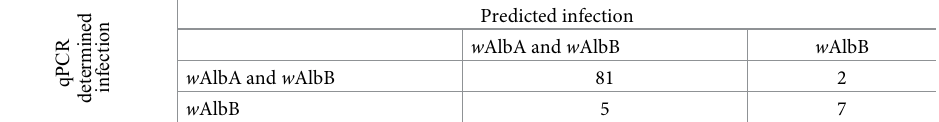
There was a significant association between w AlbA and w AlbB infections in superinfected Ae . albopictus females in most populations (Fig 6A–6F). Correlations between densities of the two infections were always positive and significant (P < 0.05) in the samples and regression analyses where the w AlbA density was used to predict the density of w AlbB were also always significant with positive slopes in each case (Fig 6). On the other hand, we found no associa- tions between the density of the infections in males in the two populations with moderate sam- ple sizes ( > 10) available for analyses (Fig 6G and 6H). Table 4. Test set confusion matrix of Wolbachia infection classification for w AlbB and superinfected ( w AlbA